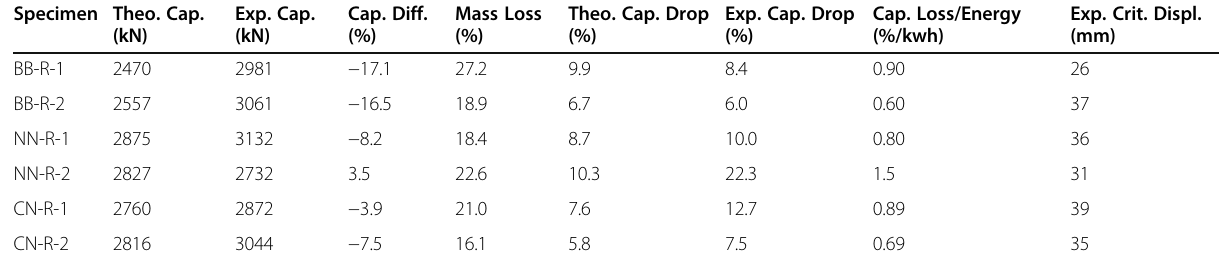
Table 5 Comparison of axial compressive capacity of corroded specimens using experimental results and theoretical capacity from Eq. (9) Specimen Theo. Cap.